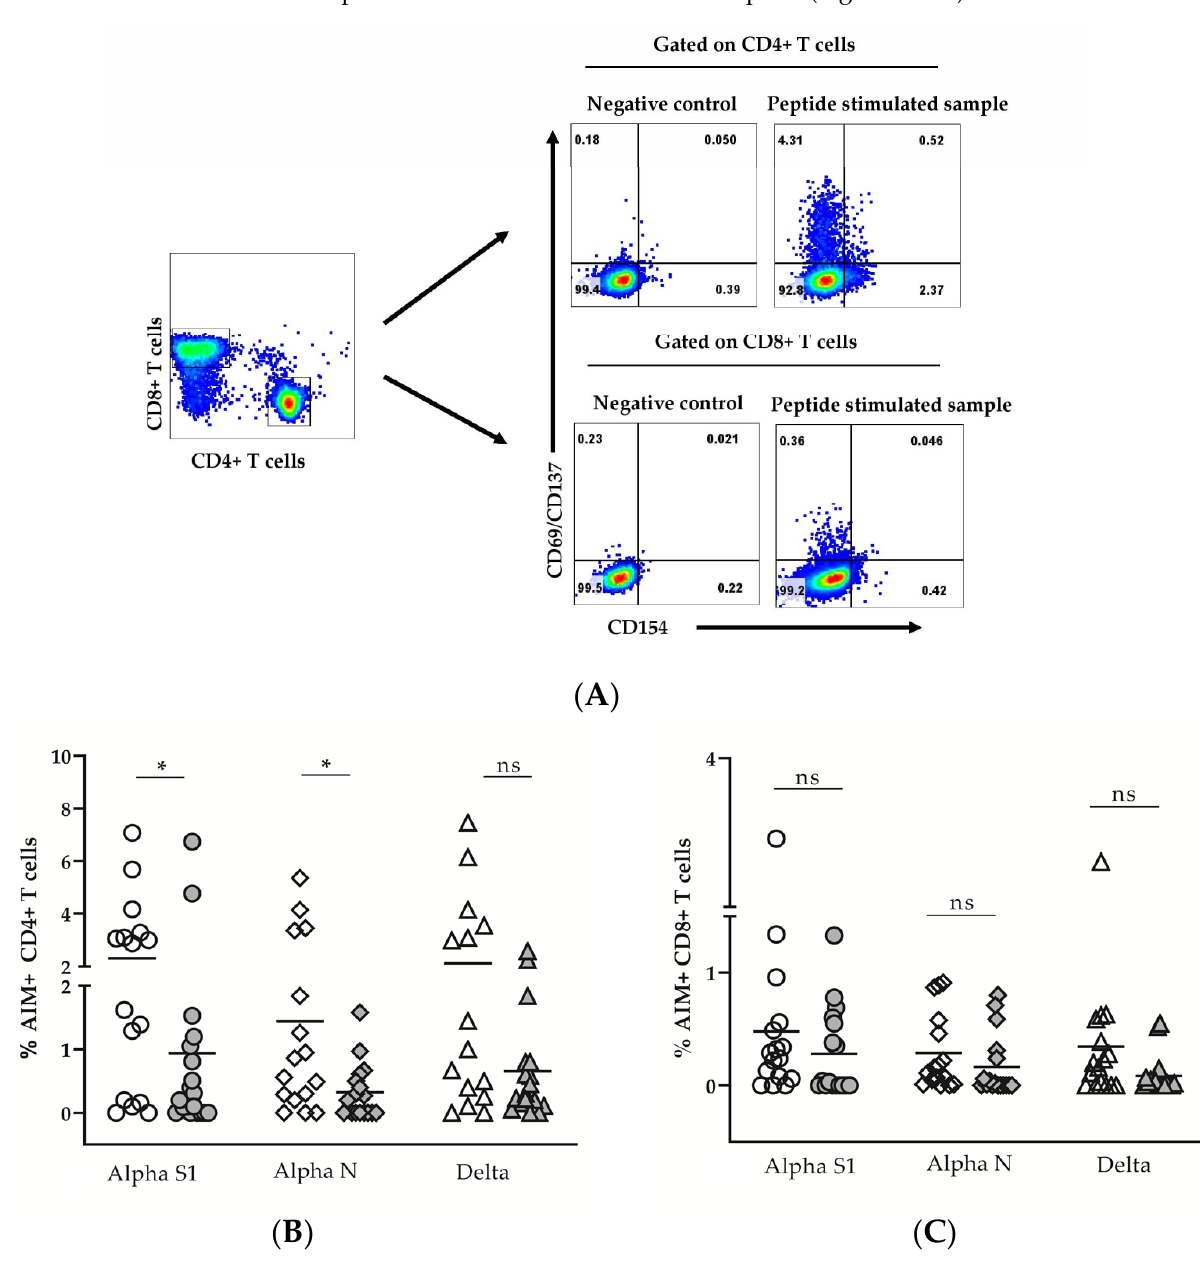
Figure 2. Flow-cytometry detection of AIM+CD4+ and AIM+CD8+ T cells. Gating strategy ( A ). The percentage of AIM+ (CD69+CD137+ and/or CD154+) virus-specific cells within gated CD4+ and CD8+ T cells was determined after subtracting the values obtained for the negative control. Individual values for AIM+CD4+ ( B ) and AIM+CD8+ T cells ( C ), specific to peptide pools from alpha S1 (circles), alpha N (diamonds) and delta (triangles) variants. The responses before (open symbols) and beyond (grey symbols) 9 months after the infection are compared. (* p < 0.05; ns, non-significant; MW) .